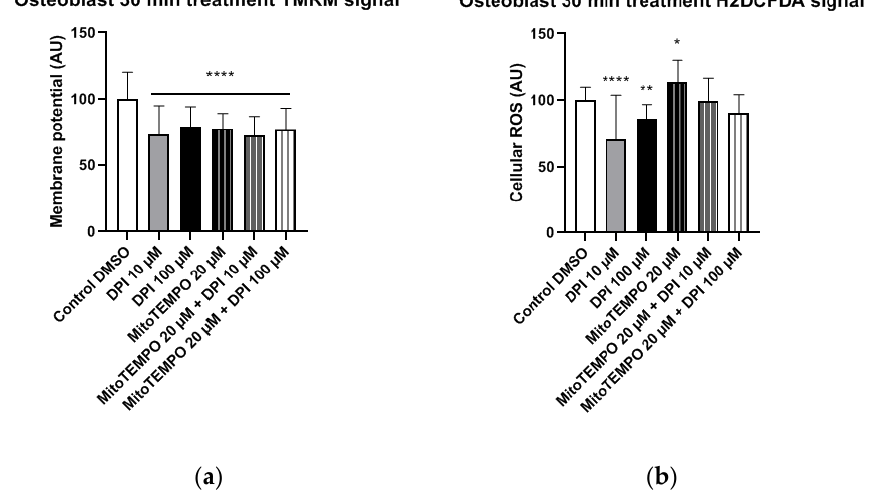
Figure 7. Mitochondrial membrane potential and cellular ROS levels 30 min after treatment of osteogenic-induced hBMSCs (osteoblast-like cells) with diphenyleneiodonium chloride (DPI) and MitoTEMPO. ( a ) Changes in the mitochondrial membrane potential. ( b ) Changes of the cellular ROS levels due to nicotinamide adenine dinucleotide phosphate oxidase (NOX) inhibition at high and low concentrations of DPI. Data is represented as means + SD (error bars) ( n = 24; each point was obtained by analyzing 2–4 single cells. * p < 0.05, ** p < 0.01, and **** p < 0.0001; one-way ANOVA followed by multiple comparison post-hoc Fisher’s LSD test.